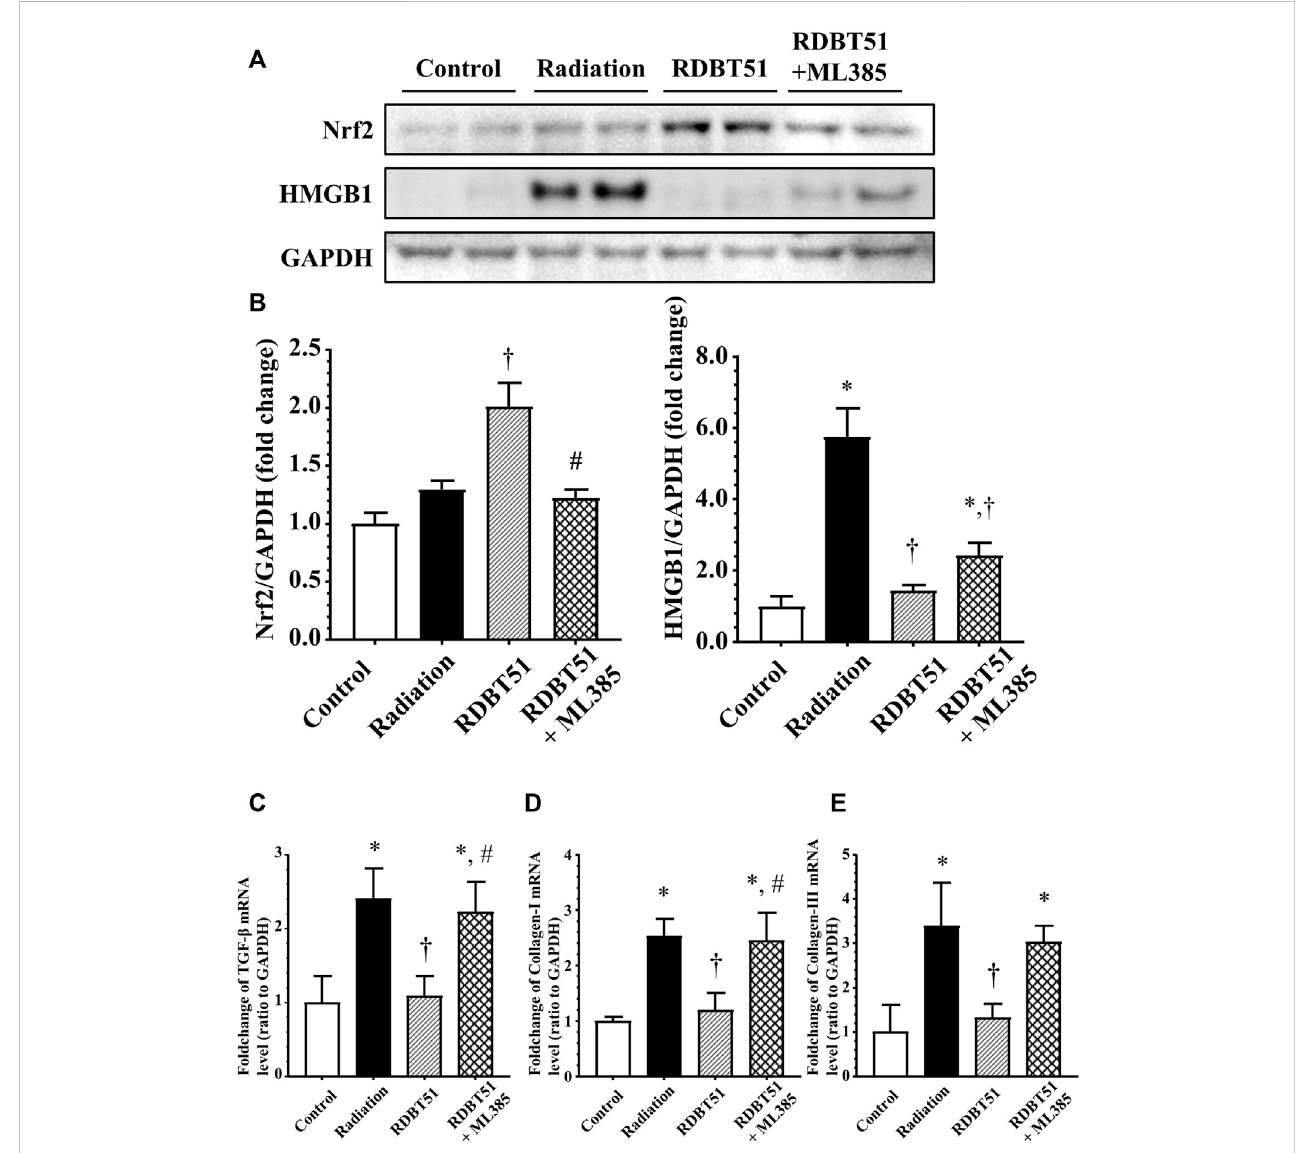
inhibitor of Nrf2) for 48 h and then collected for analyses. (A) Representative western blot bands; (B) Quantitative results of Western blot; (C) , (D) , and (E) Quantitative results of real-time qPCR for TGF- β , Collagen-I and Collagen-III. * p < 0.05 versus Control; † p < 0.05 versus Radiation; # p < 0.05